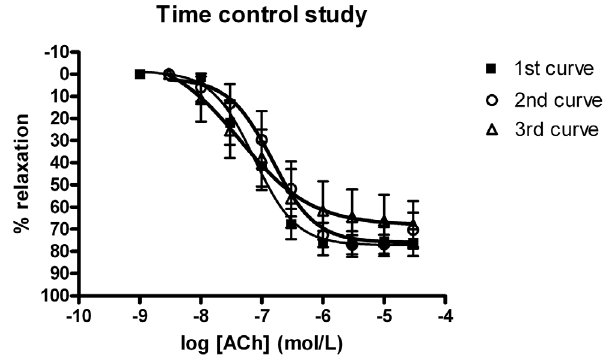
Figure 4. Association between diastolic blood pressure and nitric oxide-response ( D pEC 50 ) in controls (r= 2 0.59; p , 0.05) and ESRD (r= 2 0.44; p=0.10), Pearson one-tailed correlation.